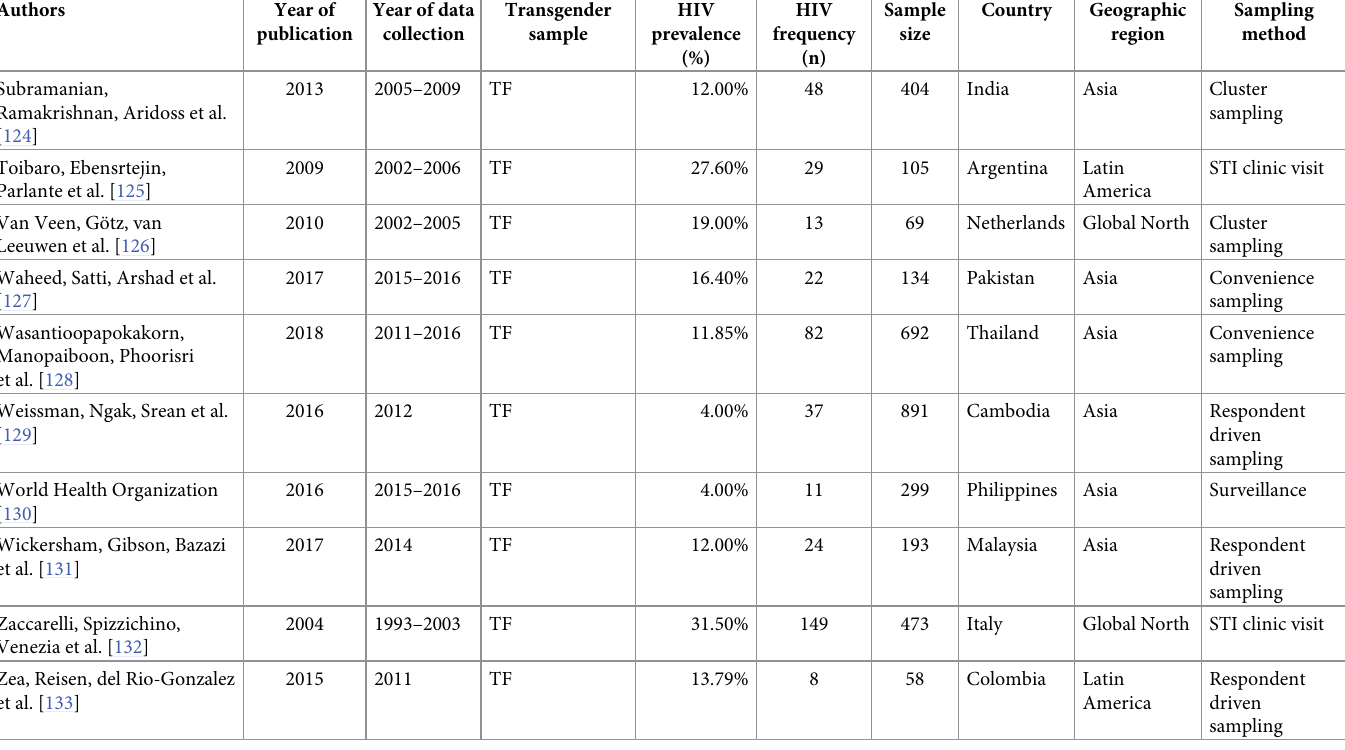
years of age in the countries from which we had prevalence data for trans feminine individuals, matched to year of data collection, was 21.5 (95% CI 6.3–73.7). In Latin America ( n = 7917), standardized prevalence was 25.9% (95% CI 20.0% - 31.8%) and the overall OR for HIV infec- tion, compared to individuals over 15 years of age, was 95.6 (95% CI 73.7–122.7). In Asia ( n = 14,798), the standardized HIV prevalence was 13.5% (95% CI 2.3% - 17.7%) and the over- all OR was 68.0 (95% CI 42.9–107.8). Lastly, in the Global North, thus in Australia, Europe, and North America ( n = 24,697), the standardized HIV prevalence was 17.1% (95% CI 13.1% - 21.1%) and the overall OR for HIV infection was 48.4 (95% CI 28.2–83.9). The standardized HIV prevalence by sampling method is reported in Table 5. The stan- dardized HIV prevalence among transgender individuals when respondent driven sampling was employed (33 studies) was 23.3% (95% CI 18.0% - 28.4%). When prevalence rates were ascertained via STI clinic visits (26 studies), standardized prevalence was 17.4% (95% CI 12.2% - 22.7%). When convenience sampling was employed (14 studies), standardized prevalence was 19.7% (95% CI 14.8% - 24.5%) and when cluster sampling was employed (11 studies), the standardized prevalence was 19.6% (95% CI 14.4% - 24.9%). The remaining sampling methods were relatively infrequently employed (i.e., employed in 5 or fewer studies). Next, we looked at the potential role of PrEP in reducing HIV prevalence among trans fem- inine individuals. Prior to the introduction of PrEP (1997–2011), the standardized HIV preva- lence in US-based studies was 18.4% (95% CI 14.8% - 22.0%; Table 6) and the overall OR for HIV infection, compared to individuals over 15 years of age in the USA, was 53.5 (95% CI 29.7–96.5). After the introduction of PrEP (2012–2017), the standardized HIV prevalence